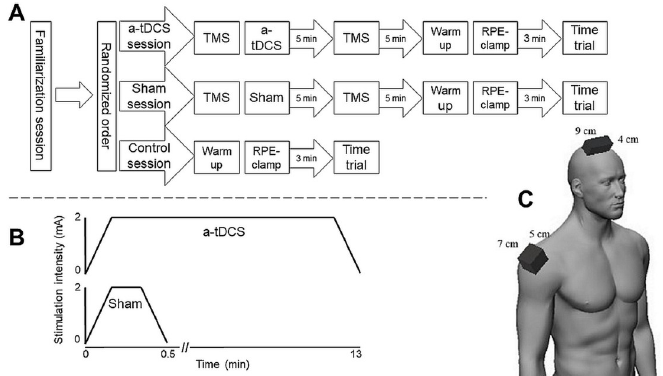
Fig 1. A: Illustrates the experimental design of the present study. B: Illustrates the applied stimulation protocol for a- tDCS and sham stimulation. C. Illustrates the placement of the electrodes, with the anode centered above the Cz, and the cathode centered above the right deltoid muscle. a-tDCS = anodal transcranial direct current stimulation. TMS = Transcranial Magnetic Stimulation (Twelve participants completed the TMS protocol). RPE = Rate of perceived exertion. mA =